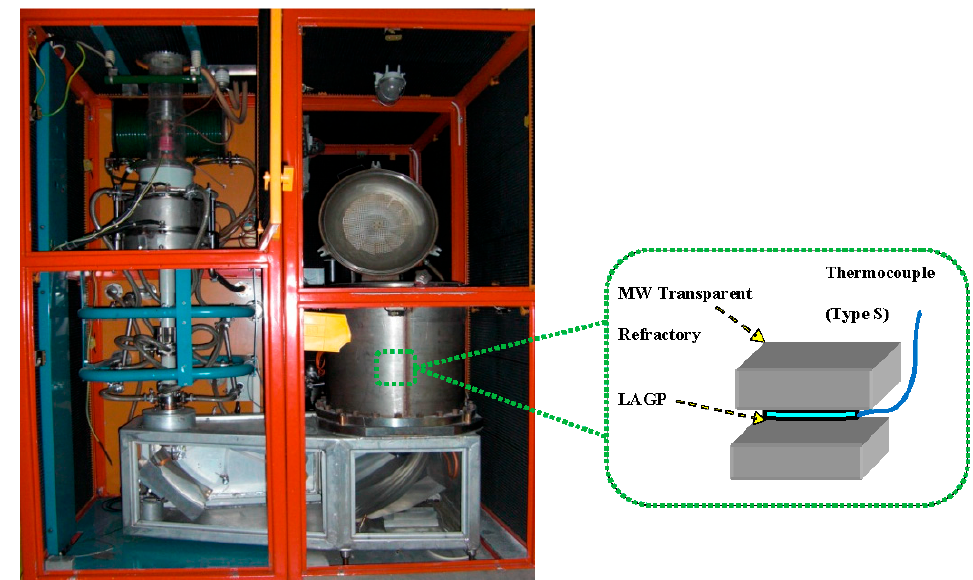
Figure 1. Thirty GHz microwave gyrotron system with a schematic of the lithium aluminum germanium phosphate (LAGP) glass crystallization setup.